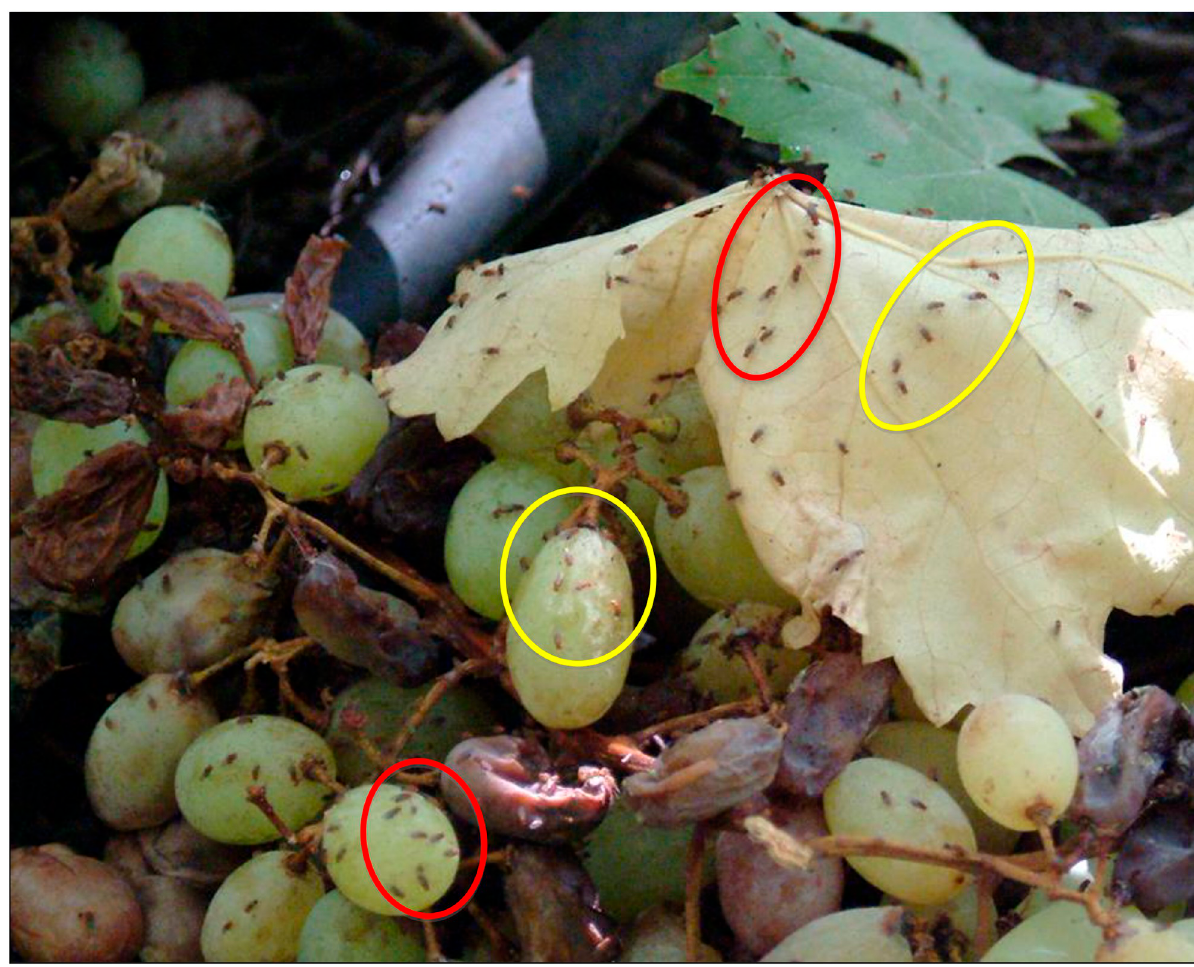
Fig 3. The same photograph of Fig 2 at double